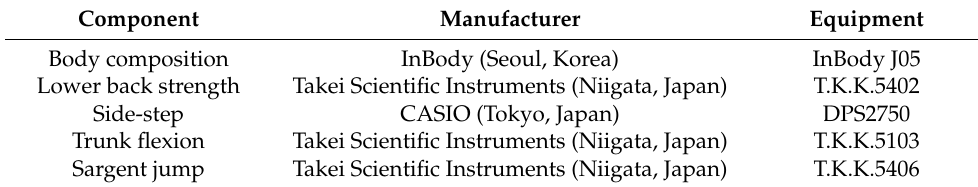
Table 2. Measuring equipment for each physical fitness component.